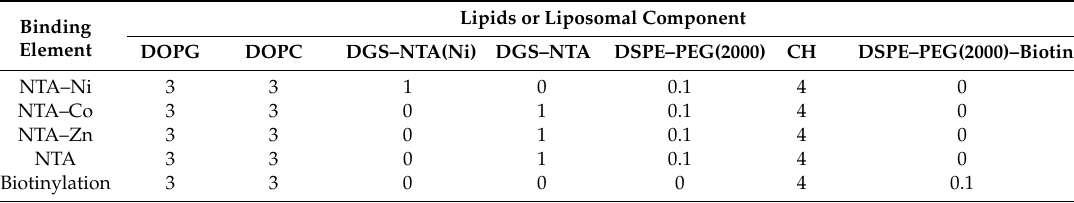
Table 1. Liposome composition with regards to binding